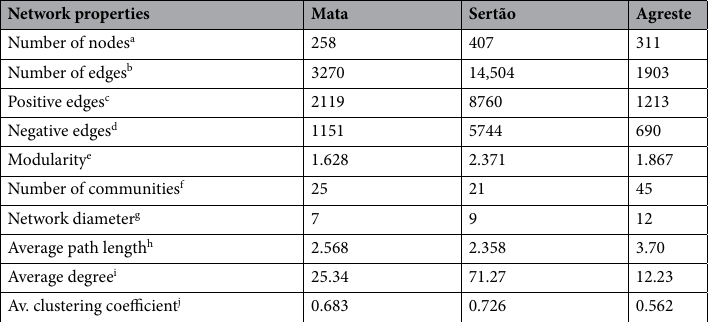
Table 2. Correlations and topological properties of microbiome networks from soil of Mata, Sertão, and Agreste. a Microbial taxon (at genus level) with at least one significant ( P < 0.01) and strong (SparCC > 0.7 or < −0.7) correlation; b Number of connections/correlations obtained by SparCC analysis; c SparCC positive correlation (> 0.7 with P < 0.01); d SparCC negative correlation (< −0.7 with P < 0.01); e The capability of the nodes to form highly connected communities, that is, a structure with high density of between nodes connections (inferred by Gephi); f A community is defined as a group of nodes densely connected internally (Gephi); g The longest distance between nodes in the network, measured in number of edges (Gephi); h Average network distance between all pair of nodes or the average length off all edges in the network (Gephi); i The average number of connections per node in the network, that is, the node connectivity (Gephi); j How nodes are embedded in their neighborhood and the degree to which they tend to cluster together